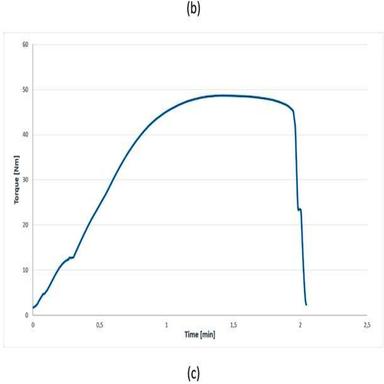
Typical fracture surfaces of both THG-5 and THG-25 joined by GC2 and tested in torsion (FZJ) at 700 °C (a) and 800 °C (b) (pictures refer to THG-25). Typical torque (T, Nmm) versus time (minutes, 4°/min) of a THG-25 joined sample tested at 800 °C (c).